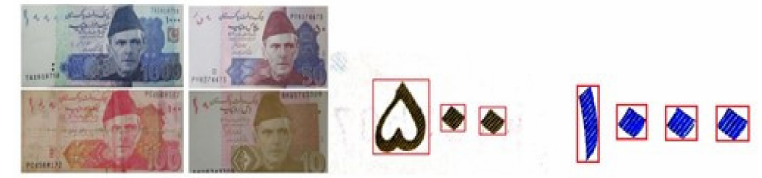
Figure 2. Test images of Pakistani currency